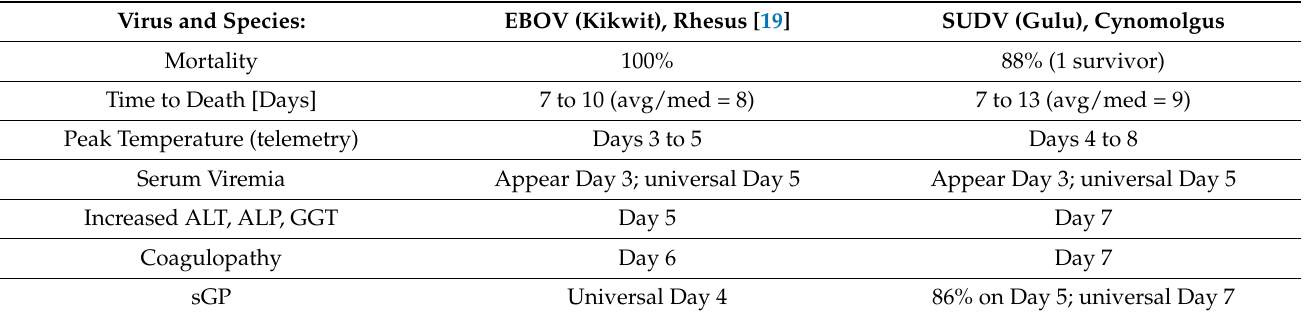
Table 8. Comparison of Disease in Macaques Exposed via IM route to EBOV or